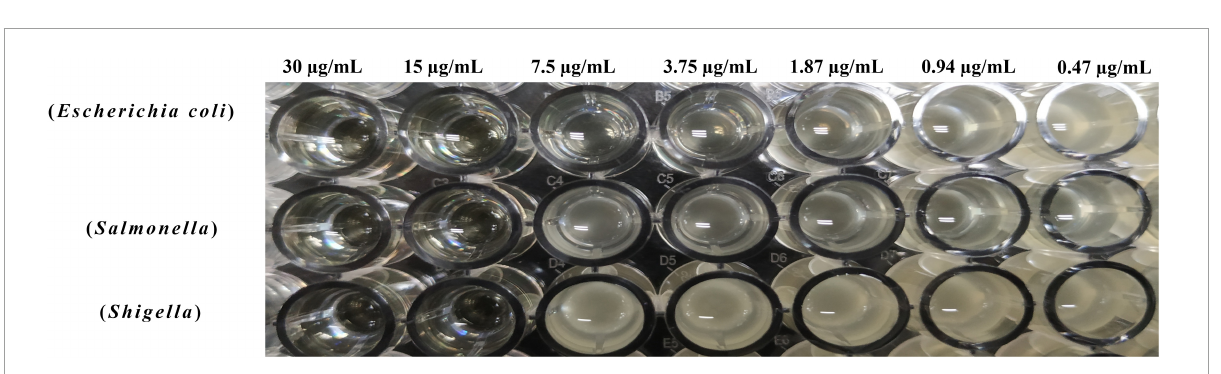
FIGURE5 LC-MS/MS spectrum of the BVYA1 lipopeptide. (A) MS spectrum of the BVYA1 lipopeptide, (B) MS/MS spectra of [M + H] + ions at m/z 980.62, (C) MS/MS spectra of [M + H] + ions at m/z 994.66, (D) MS/MS spectra of [M + H] + ions at m/z 1008.66.